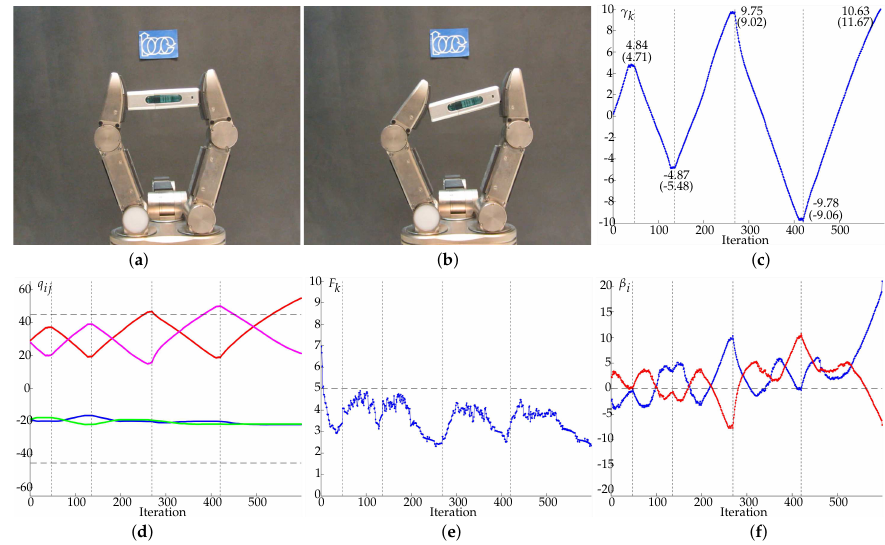
Figure 15. Example 5. ( a ) Initial grasp. ( b ) Final grasp. ( c ) Evolution of the object orientation γ k with sequential setpoints 5, − 5, 10, − 10 and 15 degrees. ( d ) Evolution of the joints values in degrees, q 11 in blue, q 12 in red, q 21 in green, q 22 in magenta. ( e ) Average force F k in Newtons, the dashed line indicates F d . ( f ) Angles β i in degrees, β 1 in blue and β 2 in red (the dashed line indicates the optimal value of β i ).